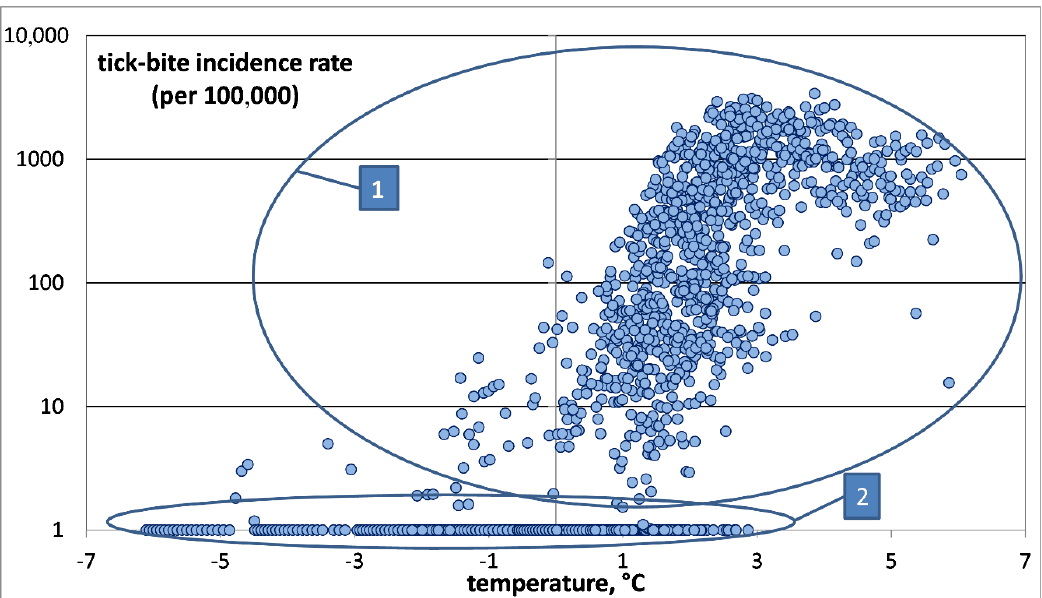
Figure 3. Tick-bite incidence rate (ordinate) versus average annual model air temperature (abscissa) for all administrative units of the Arkhangelsk Oblast, Karelia and Komi. TBIR on a logarithmic scale. Separate sample groups are highlighted in the figure. The description is given in the text.